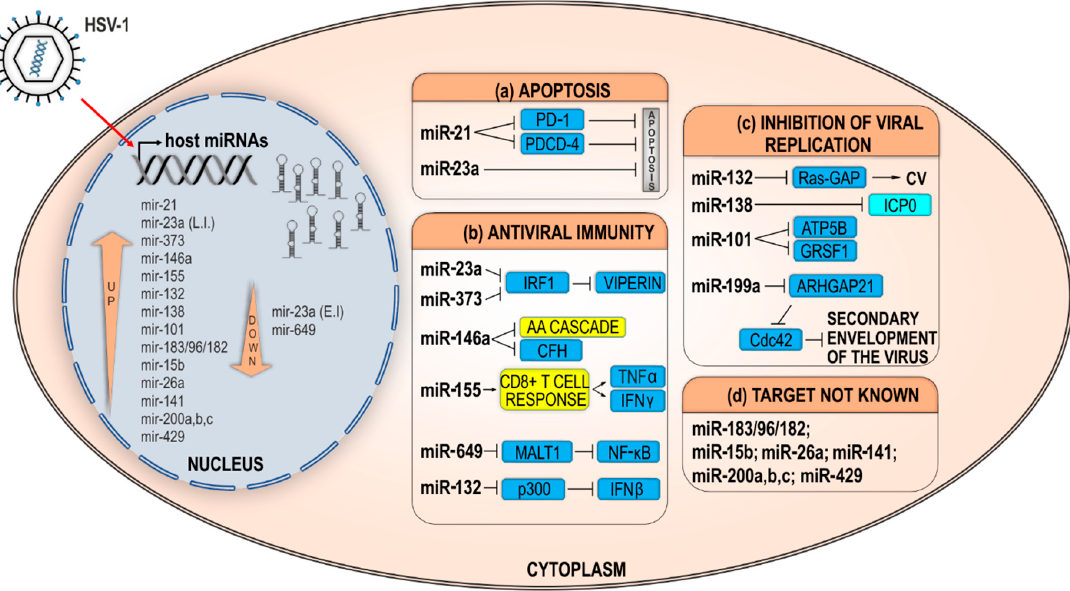
Figure 2. HSV-1 deregulates host miRNAs. A schematic representation of reported deregulated host miRNAs in HSV-1 infection and miRNAs with pro/antiviral functions. HSV-1 infects cells and triggers massive changes in host cell miRNAome. Many miRNAs have been found to be upregulated (arrow up within the nucleus) or downregulated (arrow down in the nucleus). These miRNAs regulate different host (blue boxes) or viral transcripts (light blue box) with functions in ( a ) regulation of apoptosis, ( b ) antiviral immunity, ( c ) inhibition of viral replication, and ( d ) miRNAs with targets not known depicted in separate boxes. During early infection (EI), miR-23a is downregulated, while later in the infection (LI) miR-23a is upregulated. The exact targets of miR-155 and miR-146a have not been identified; however, they regulate host immune response (yellow boxes) by regulating T-cell differentiation and the arachidonic acid cascade (AA cascade) pathway, respectively. Upregulated miR-132 activates Ras by removing Ras-GAP, leading to corneal neovascularization (CV). Neuron-specific miR-138 regulates virus protein ICP0. Arrows indicate positive regulation. PD-1: Programmed cell death protein 1; PDCD-4: Programmed cell death protein 4; IRF1: Interferon regulatory factor 1; CFH: Complement factor H; TNF α : Tumor necrosis factor alpha; IFN β / γ : Interferon beta/gamma; MALT1: Mucosa-associated lymphoid tissue lymphoma translocation gene 1; NF- κ B: Nuclear factor kappa-light-chain-enhancer of activated B cells; Ras-GAP: Ras–glyceraldehyde-3-phosphate; ICP0: Infected cell polypeptide 0; ATP5B: ATP synthase subunit beta; GRSF1: G-rich sequence factor 1; ARHGAP21: Rho GTPase-Activating Protein 21; Cdc42: Cell division control protein 42 homolog.